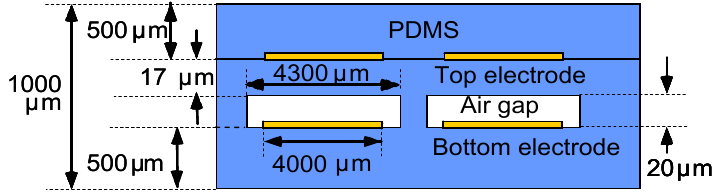
Figure 1. Schematic cross-section of established tactile sensor using polydimethylsiloxane (PDMS) and air